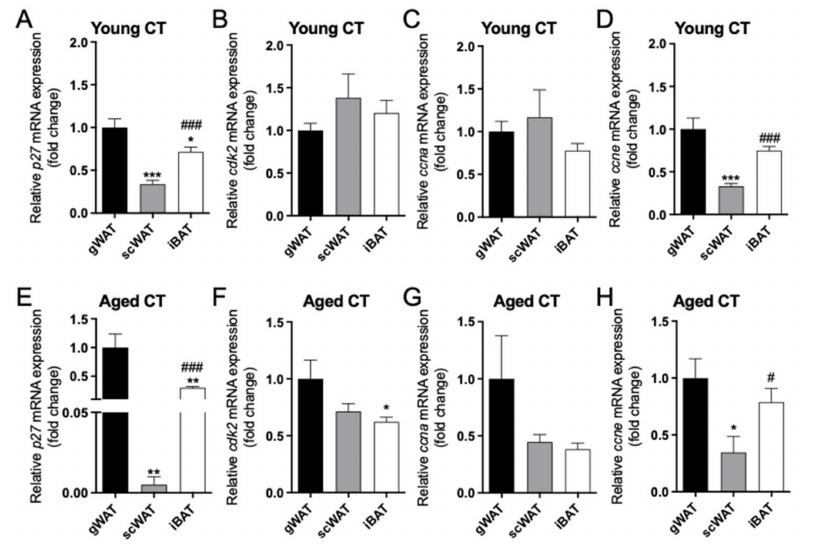
Figure 2. Differential adipose depot expression of p27 ( A , E ), cdk2 ( B , F ), ccna ( C , G ), ccne ( D , H ) , between gWAT, scWAT and iBAT in young CT mice (2-month-old) and aged CT female mice (18-month-old). Data (mean ± SEM) are expressed as fold change of gWAT, considered as 1. * p < 0.05, ** p < 0.01, *** p < 0.001 vs. gWAT; # p < 0.05, ### p < 0.001 vs. scWAT ( n =